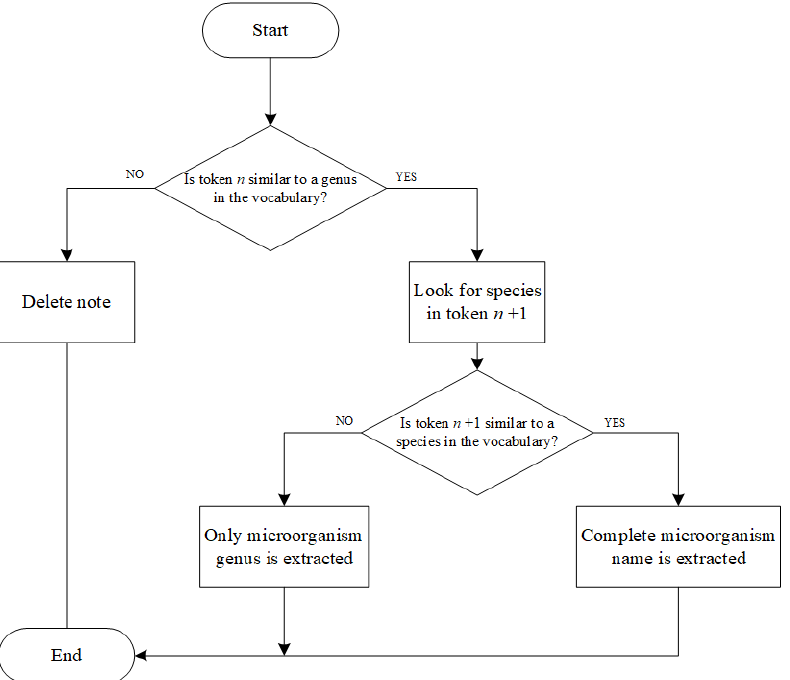
Figure 3. Microorganism name extraction decision flow. In contrast to the genus extension phase, in this process, the token “ n ” is first considered, and it is compared to the genera listed in the vocabulary. Only if a match is found (with a high similarity index) is the token “ n + 1” considered and compared to the list of species in the vocabulary that belong to the identified genus.